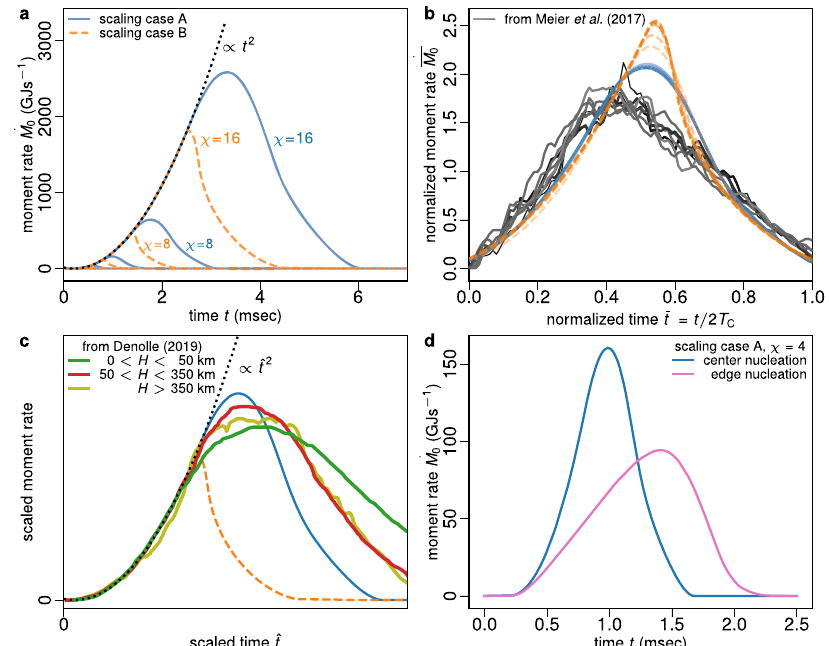
(cid:9) R R _ M ð t Þ _ M d t 1 1 t _ M d t is 1. Gray curves are natural earthquakes with M w ≥ 7 presented and the area under 0 0